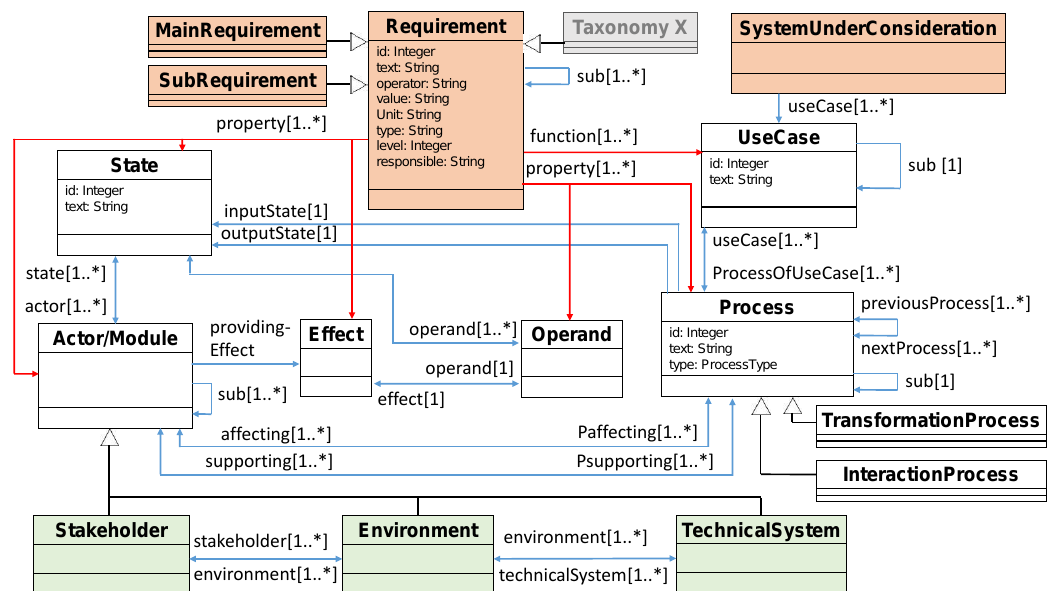
Figure 9. UML Class Diagram for Function Modelling in